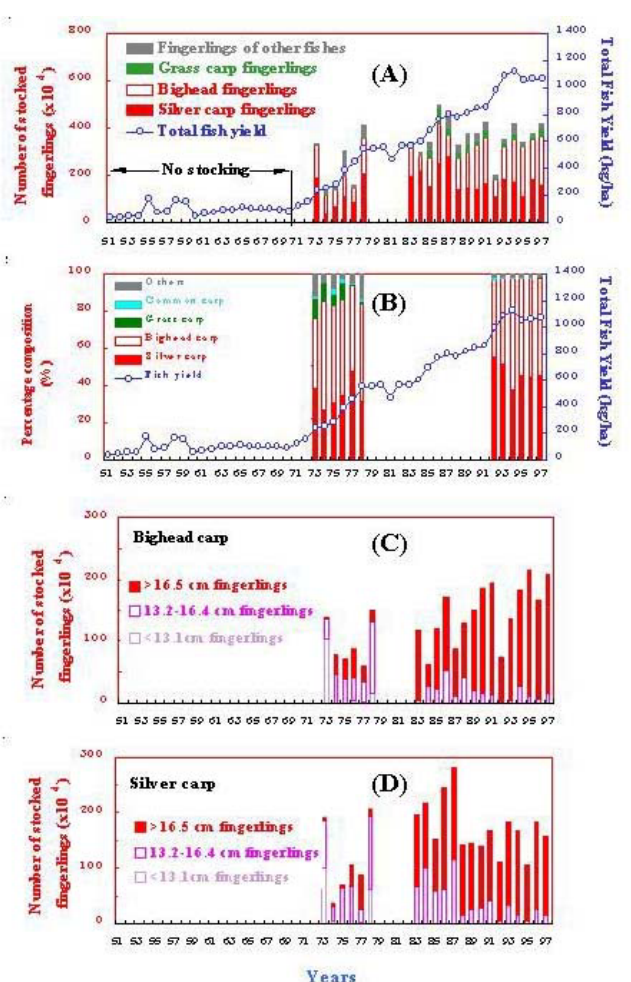
FIGURE 7. Annual fish yield and the number of stocked fingerlings (A), the percentage composition of the fish yield (B), the number of the stocked silver carp fingerlings of different sizes (C), and the number of the stocked bighead fingerlings of different sizes (D) (adapted from Xie et al.[4]). Stocking with fish-fry before the 1970s resulted in poor fish